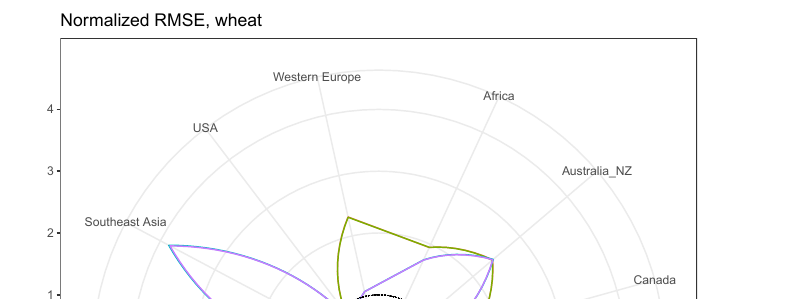
Figure 2. Global absolute bias, | b i G | (Eq. 6).